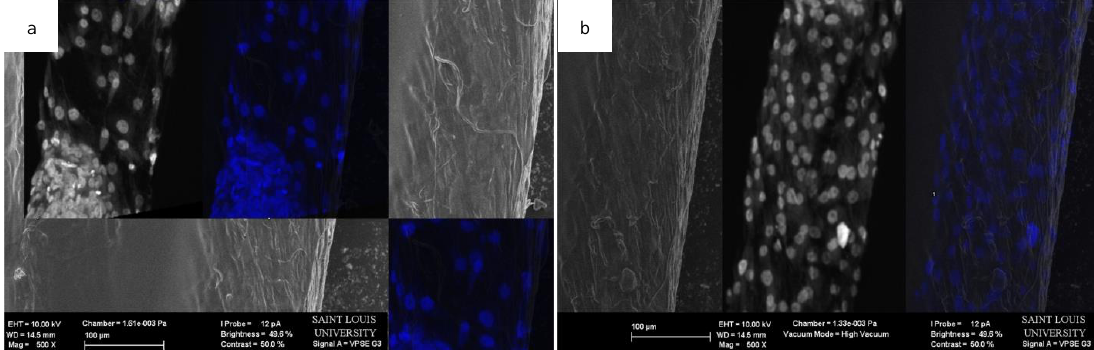
Figure 9. Representative SEM images of a HOUSteon with overlaid confocal images stained with DAPI of ( a ) an aberrant fiber and ( b ) aligned fibers.